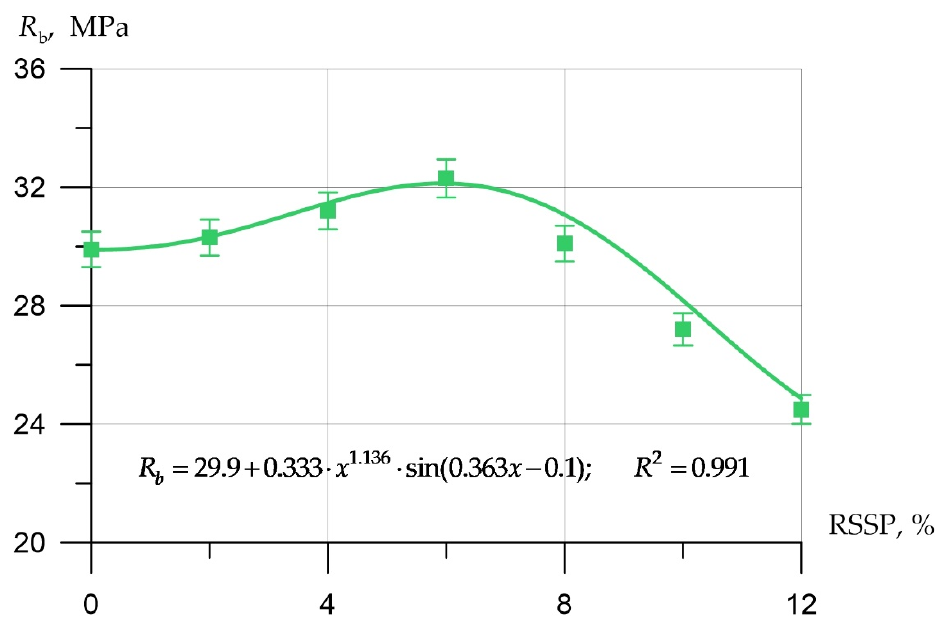
Figure 5. Axial compressive strength of snail shell powder concrete.